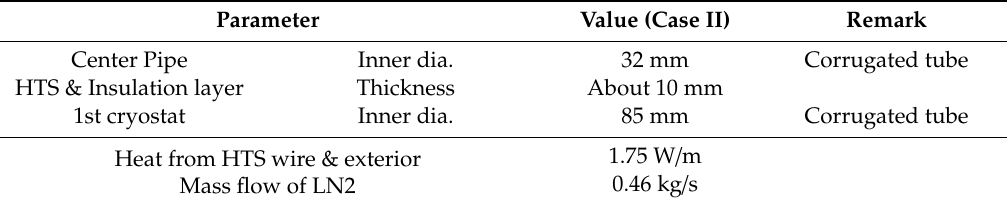
Figure 11. Real operation data of “A” project for simulation certification (1 km). Table 4. Circulation pipe specification of real installation cable for comparison with simulation.